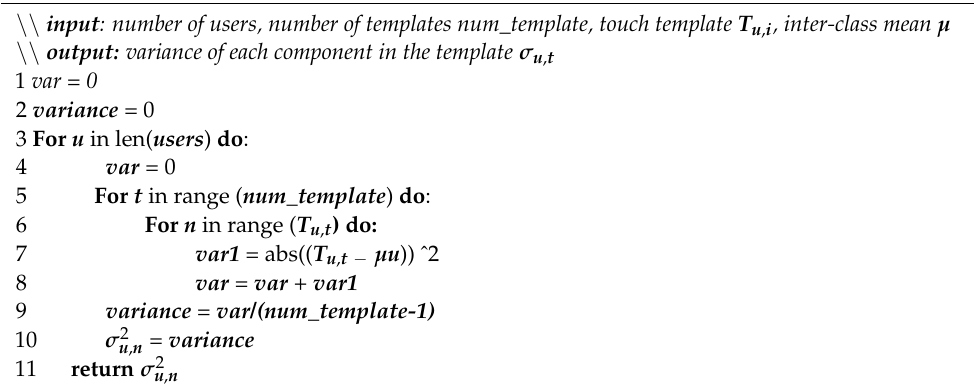
Algorithm 1 Calculate the Variance of the i th Component.